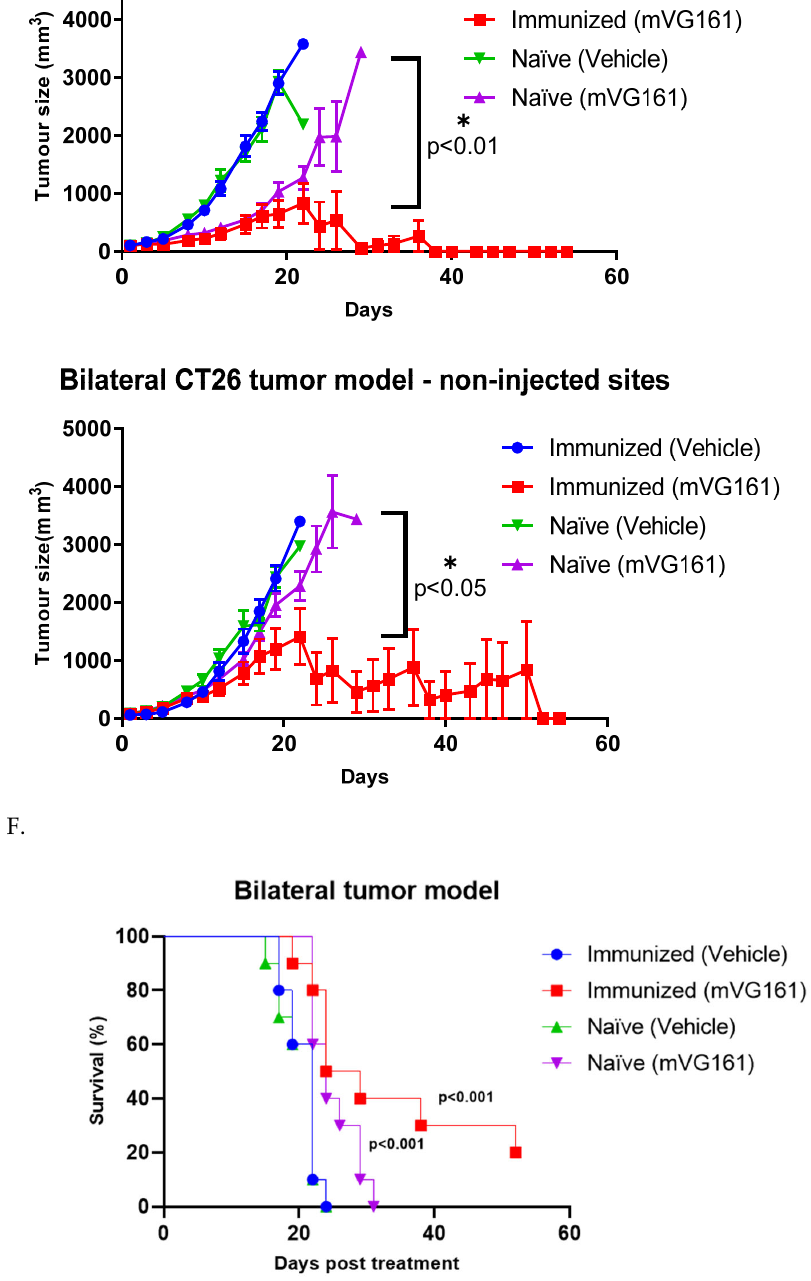
Figure 2. Efficacy and survival of CT26 mouse model treated with mVG161. ( A ) The schema of treatment protocol for Balb/c mice used in the CT26 tumor mode, ( B ) Mean tumor volume in each group in mice treated with mVG161 (single tumor model) ( C ) Survival curve for mice treated with mVG161 or vehicle, either immunized or naïve mice (single tumor model). ( D ) Immunization and treatment regimen for Balb/c mice used in the CT26 bilateral tumor model ( E ) Mean tumor volume in each group in mice treated with mVG161 (bilateral tumor model). ( F ) Survival of mice treated with mVG161 (Bilateral tumor